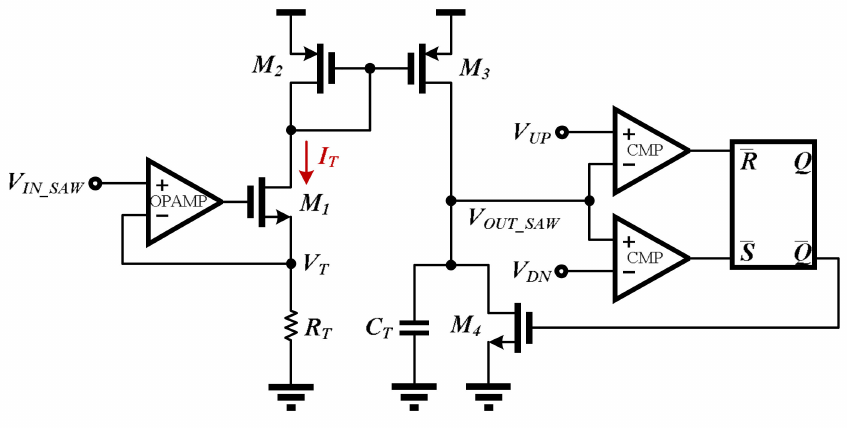
Figure 11. Sawtooth wave generator.